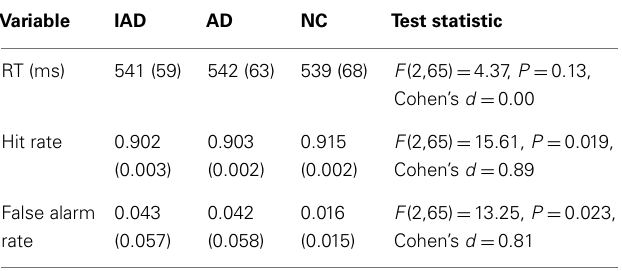
Table 3 | RTs, hit rate, and false alarm rate [mean (SD)] in IAD group